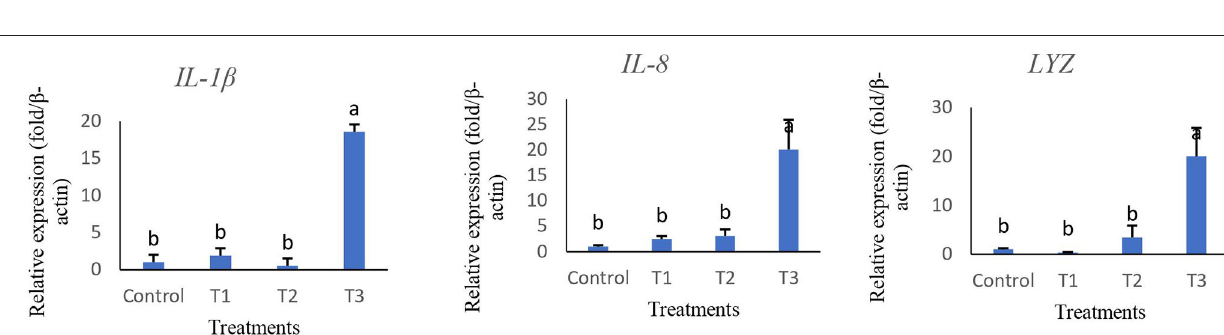
FIGURE 1 | Protease, ALP, total Ig, lysozyme, ACH 50 levels in the skin mucus of rainbow trout fed diets incorporated with different levels of zero (Control), 0.5% (T1), 1% (T2) and 2% (T3) of a mixture of herbs ( Mentha longifolia , Thymus carmanicus , Trachyspermum copticum ) for 45 days. Data represent mean ± SE. Bars with different letters indicate significant differences ( P < 0.05).